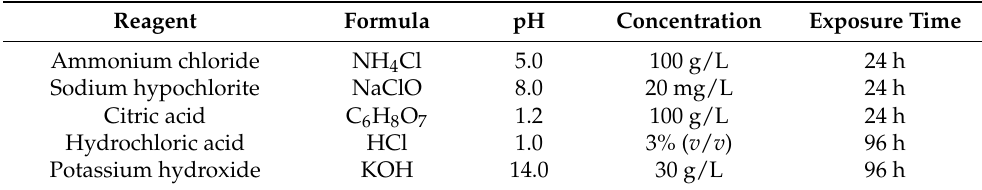
Table 2. Concentration and exposure time of the reagents used in the chemical attack resistance test.